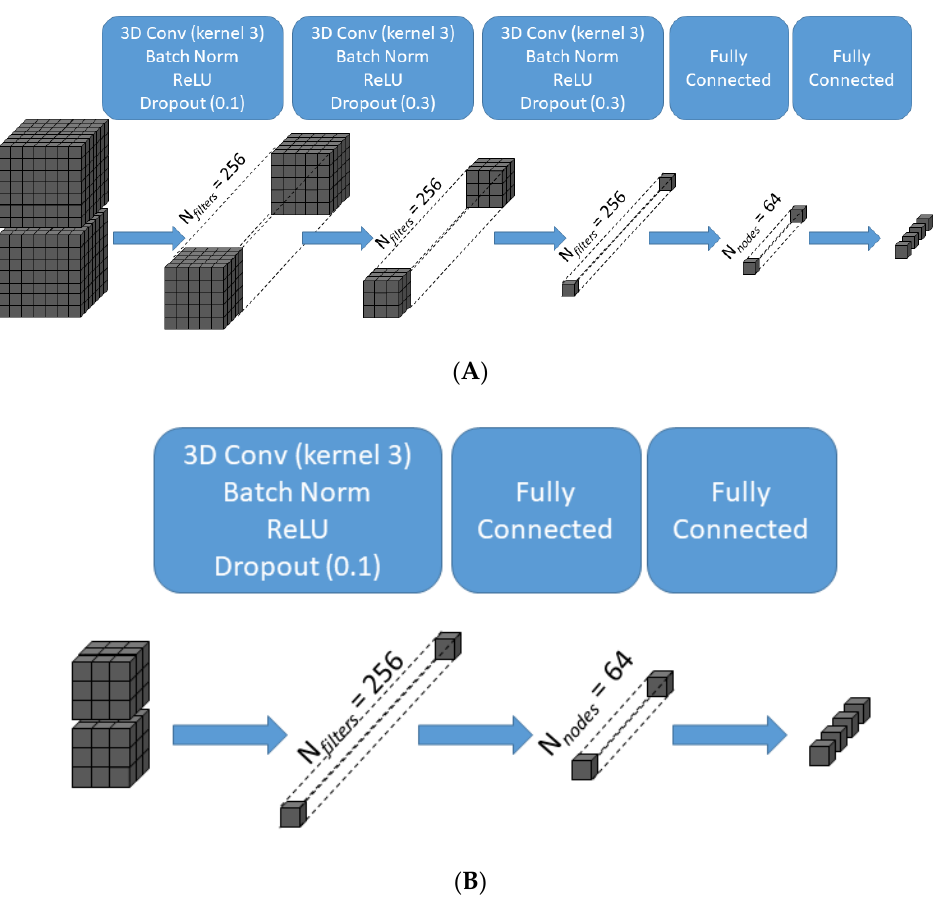
Figure 3. Schematic illustration of the transformation of data across the layers of the convolutional neural network for two representative patch sizes. For the largest patch size (X = 7, Z = 7) ( A ), the 7 × 7 × 7 × 2 input is transformed after three successive 3D convolutions of kernel size 3 × 3 × 3 without padding into a 256 ‐ element array of scalar values prior to the fully connected layers, which in turn generate the final 4 ‐ class classifier output. For the smallest patch size (X = 3, Z = 3) ( B ), one 3D convolution of kernel size 3 × 3 × 3 without padding is sufficient to generate a 256 ‐ element array of scalar values. 3D Conv = three ‐ dimensional convolutional layer; Batch Norm = batch normalization layer; ReLU = rectified linear unit activation function.